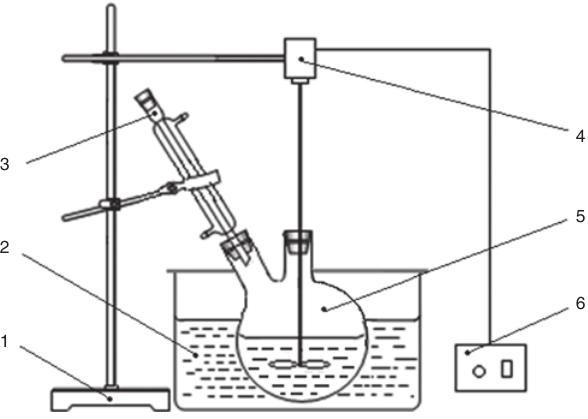
Figure 1: Schematic diagram of homogeneous precipitation experi- mental device.